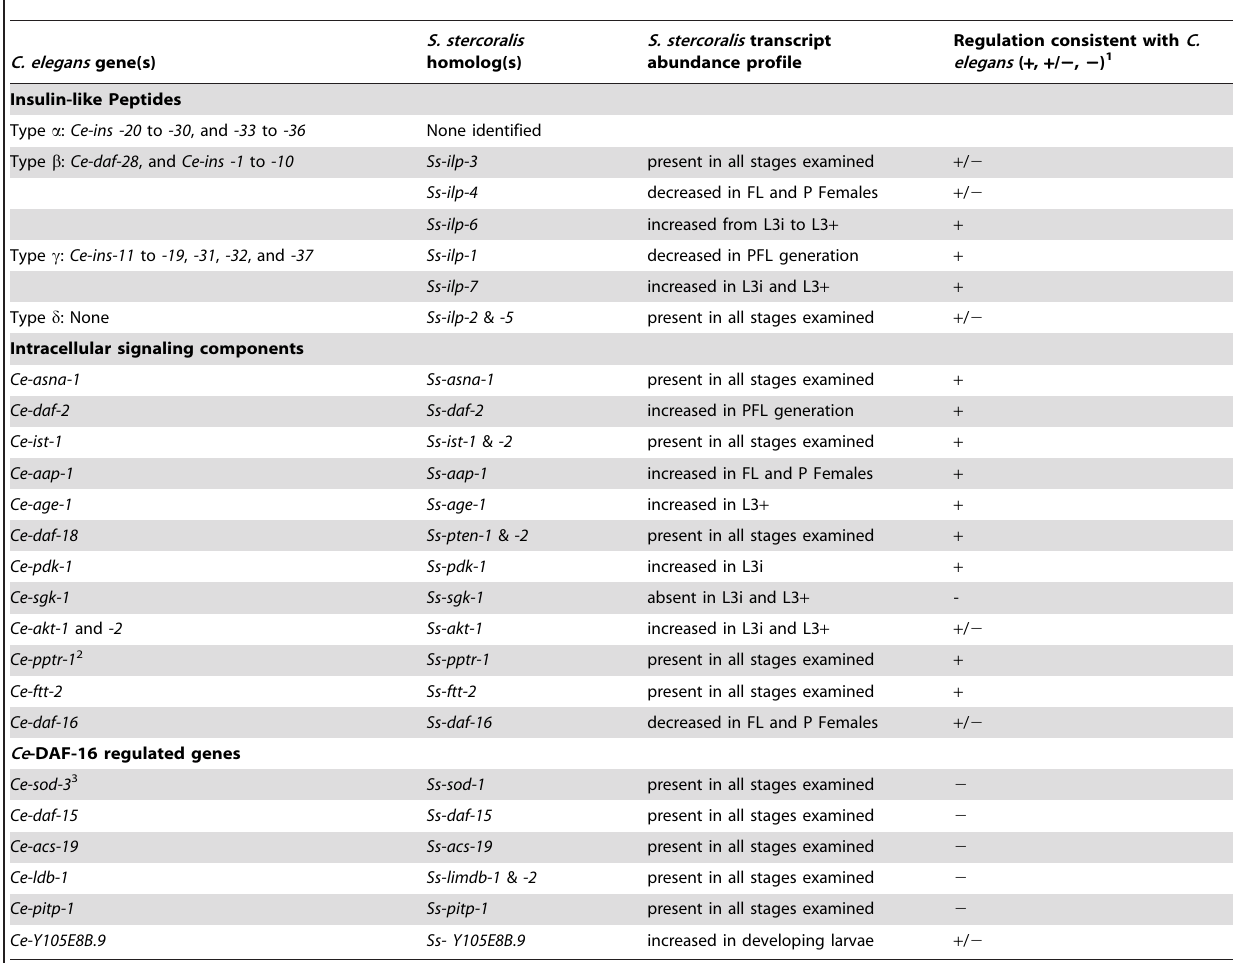
Table 2. Comparison of IIS pathway homologs and transcript abundances in S. stercoralis and C. elegans